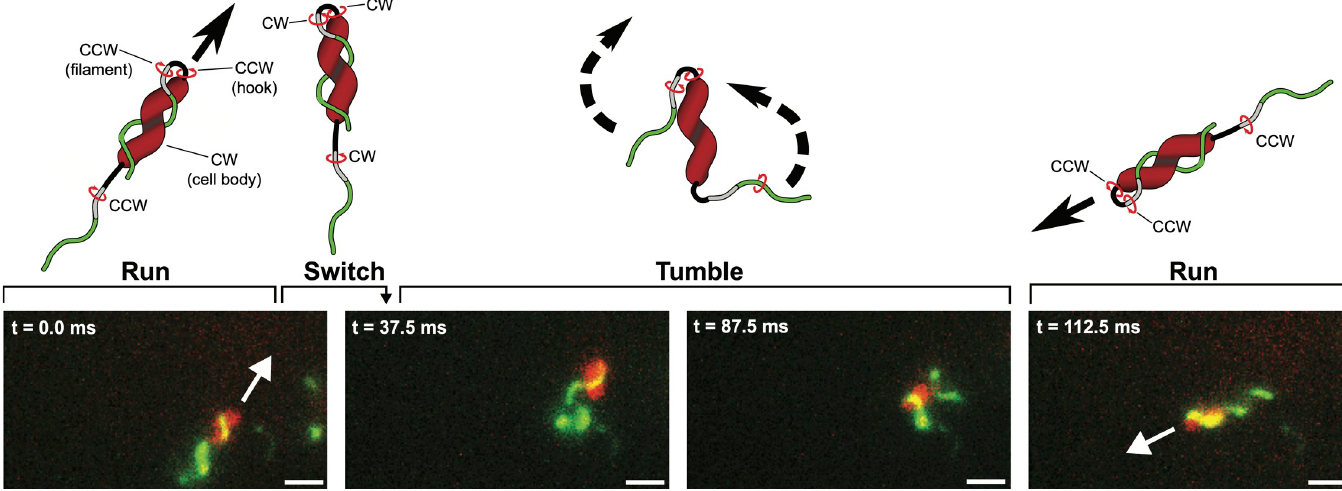
Fig 2. Changing swimming trajectory involves a switch in wrapped filament polarity. Wrapped cells change swimming direction, or tumble, by switching which filament is wrapped. The cell comes to a stop when motor rotation switches from CCW to CW, which also causes the wrapped filament to unwrap. The once lagging, unwrapped filament then wraps around the cell body while the previously wrapped filament becomes the trailing, unwrapped filament. Scale bars equal to 1.5 μ m.